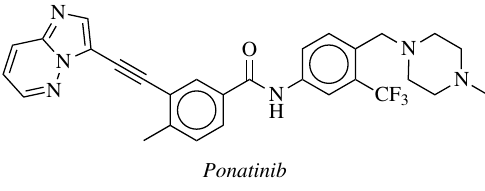
Figure 11. Chemical structure of Ponatinib